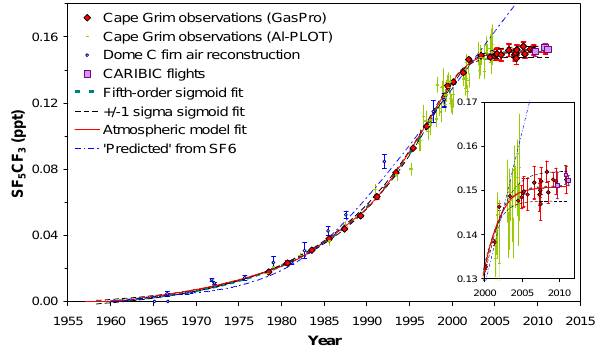
Fig. 1. The atmospheric record of SF 5 CF 3 from measurements made in air collected at Cape Grim, Tasmania; in firn air collected at Dome Concordia, Antarctica; and in air collected between 8.6 and 12.2km and 47 ◦ N–28 ◦ S from the CARIBIC aircraft. The dashed blue-green line is a least mean squares optimisation fit to a subset of the Cape Grim (see text) and Dome Concordia measurements (pre- 1978) with the uncertainty of the fit shown as black dashed lines. The red line (almost indistinguishable from the blue-green line) is the output mixing ratio from the atmospheric model run for the lo- cation of Cape Grim using the emissions shown in Fig. 2. The blue broken line shows the “predicted” SF 5 CF 3 assuming a constant ra- tio to SF 6 (see text). The inset figure is an expansion of the main graph between the dates